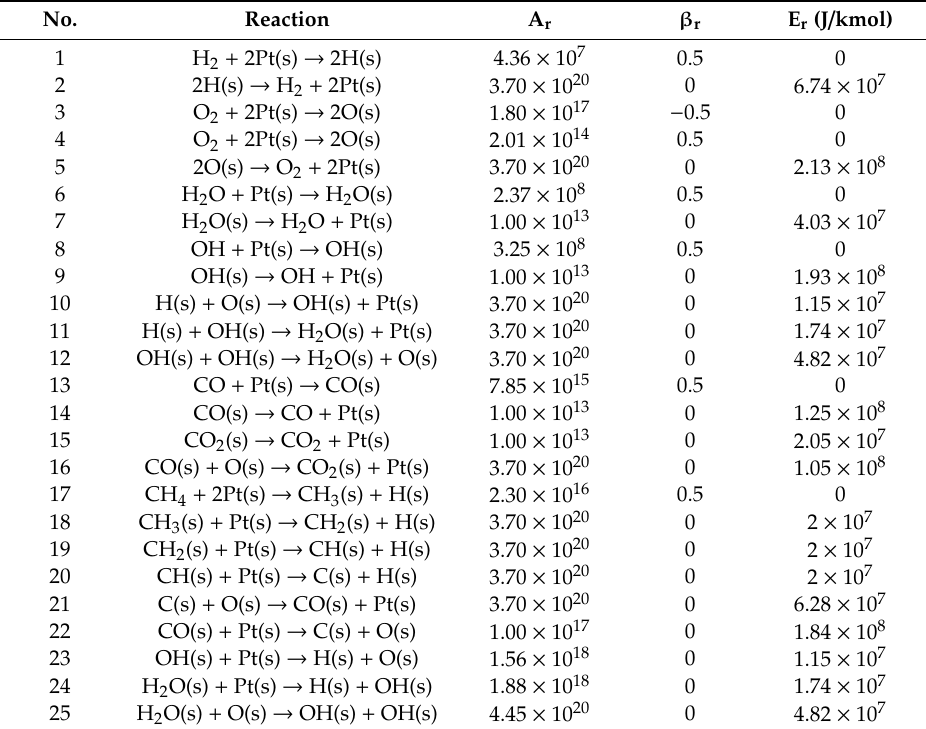
Table 2. Surface reaction